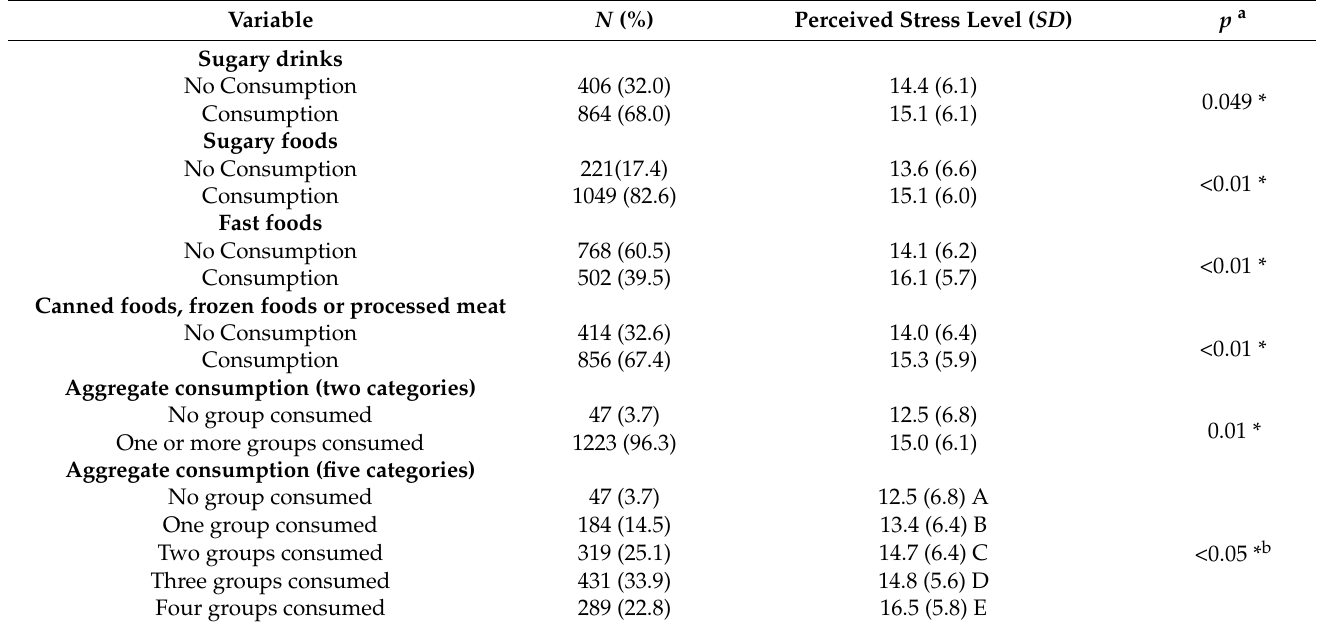
Table 2. Perceived stress by weekly frequency of ultra-processed food consumption in workers.